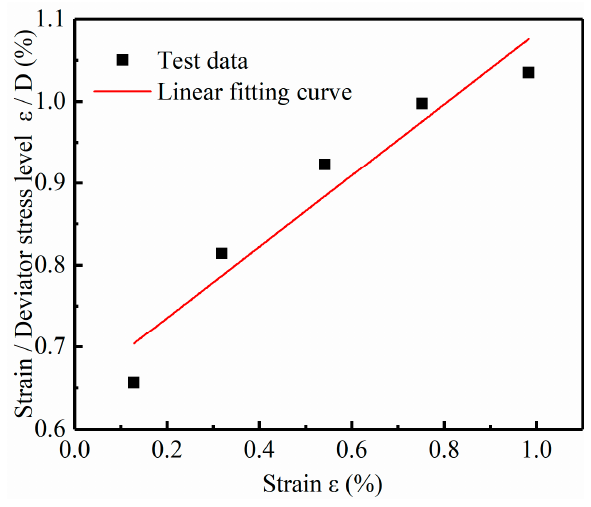
εε − ε diagram when t − − diagram when t 1 = 1 h of soft soil at 18% water content. D − D